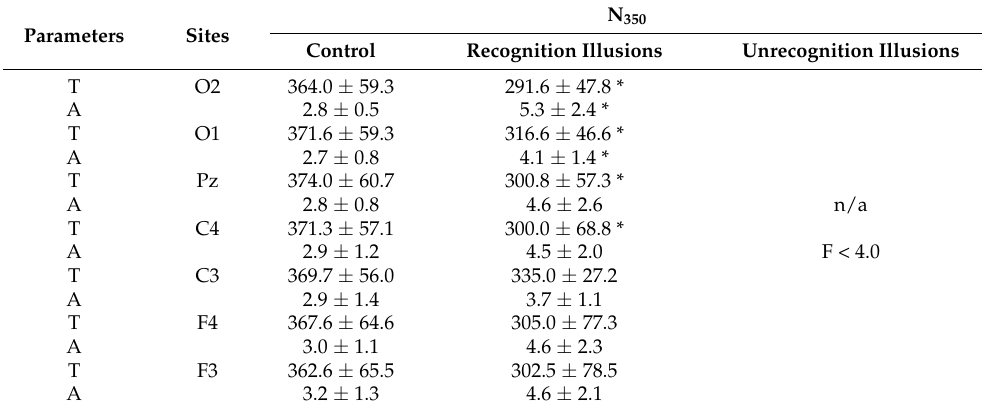
Table 3. Amplitude (A, uV) and time (T, ms) characteristics of the component N 350 ERP. Parameters